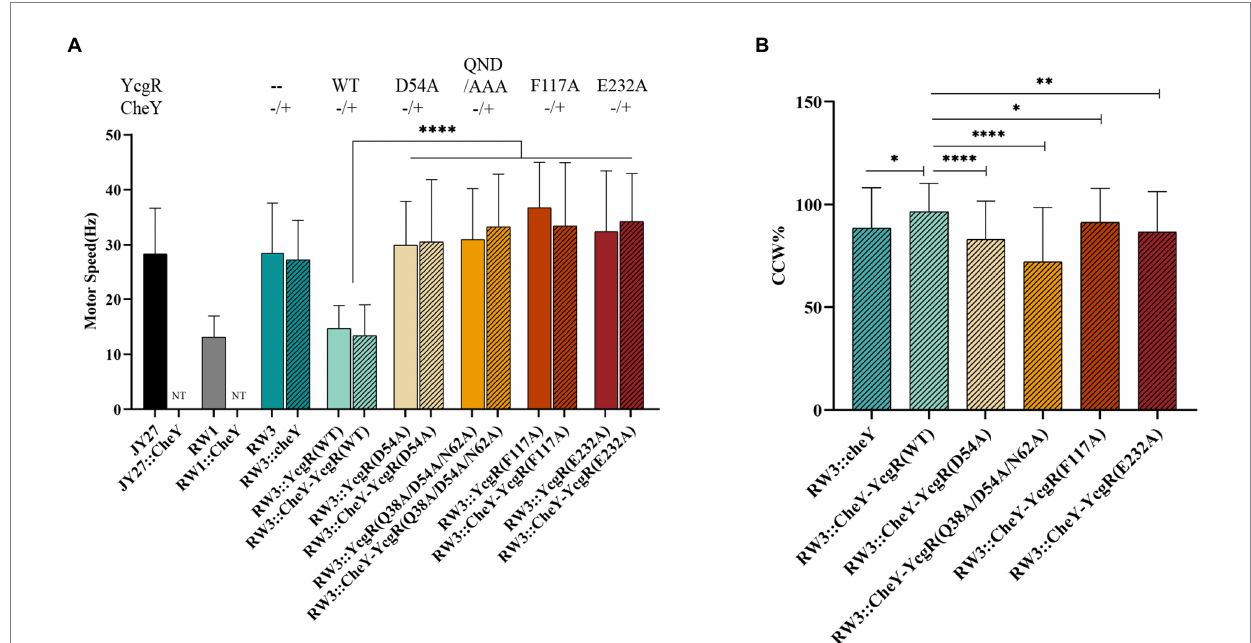
FIGURE 4 The YcgR-MotA and YcgR-FliG interactions were involved in motility regulation. (A) The flagellar rotation speeds of RW3 cells harboring YcgR variants (columns filled with color, the numbers of motors were 23, 47, 24, 28, 31, 24, 40, and 40) and those harboring both cheY and YcgR variants (column filled with lines, the numbers of motors were 44, 52, 45, 38, 45, and 45). (B) The CCW ratios of RW3 cells harboring both cheY and YcgR variants. NT, not tested. The speeds and CCW ratios were shown as mean ± SD. The results were analyzed by statistics method t -tests (and nonparametric tests). Analysis of significant differences (Two-tailed): p ≤ 0.05: *, p ≤ 0.01: **, p ≤ 0.0001: